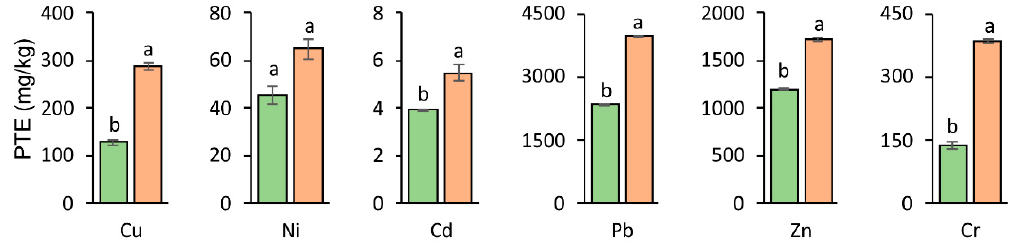
Figure 5. PTEs’ accumulation in roots ( ■ Control ■ nZVI). For a given PTE, different letters indicate significant differences in PTE concentration in roots between control soil and nZVI-amended soil.